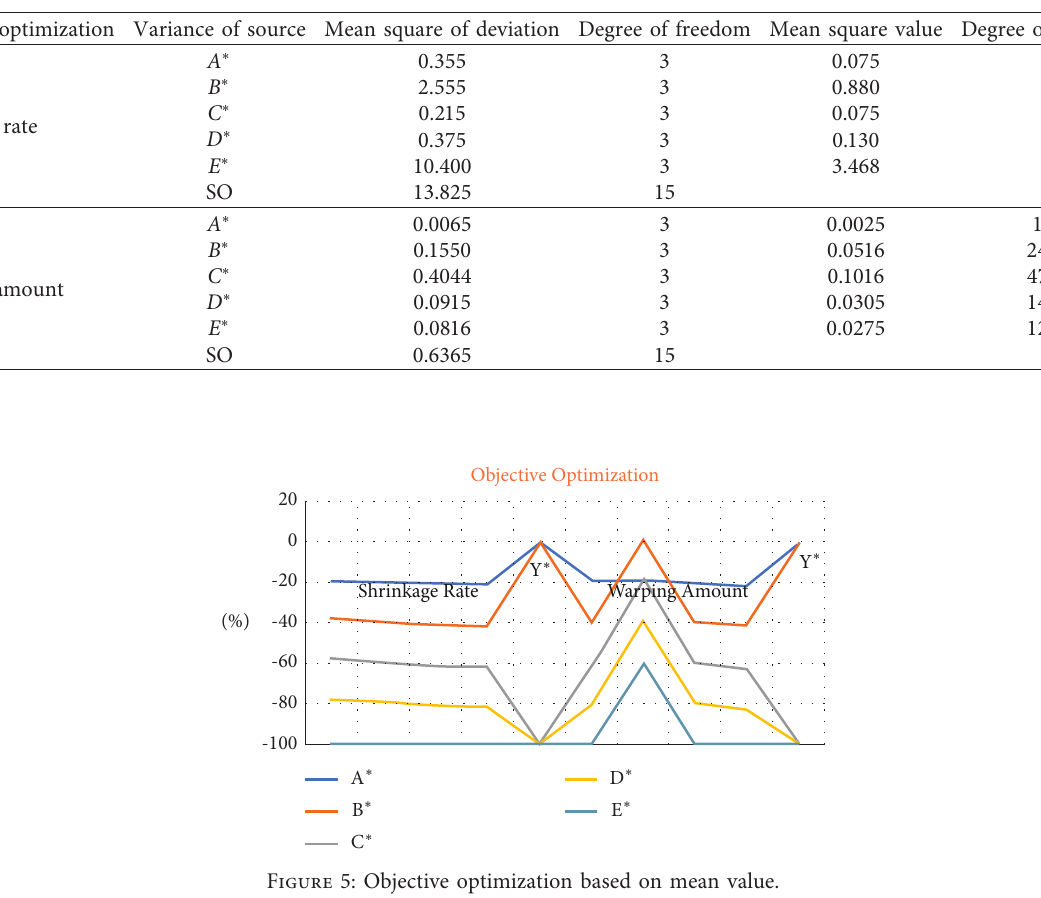
Table 5: Variance result.